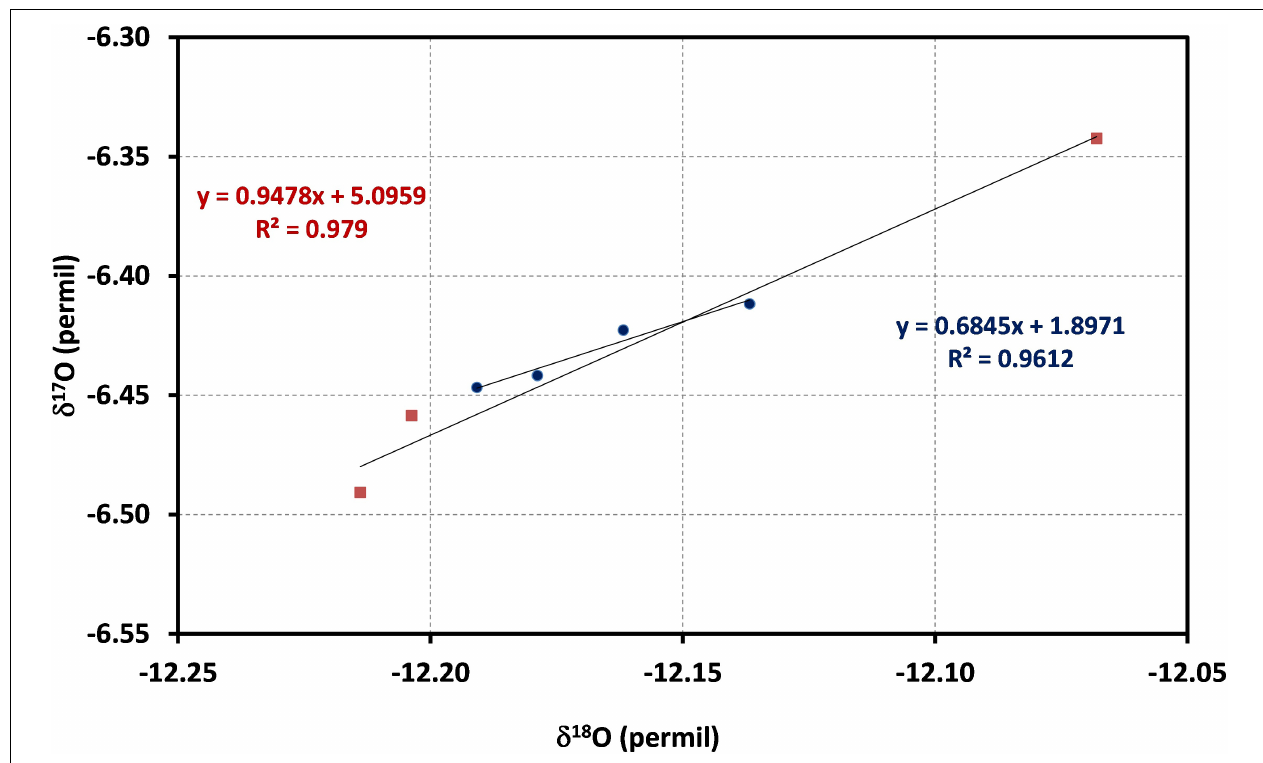
FIGURE 7 | δ 17 O and δ 18 O correlation for continuous flow (red square, last three replicates of Figure 6 ) and laser-based system (blue circle, last four replicates), PICARRO for replicates of the same standard water. Both systems show a strong correlation for δ 17 O and δ 18 O.